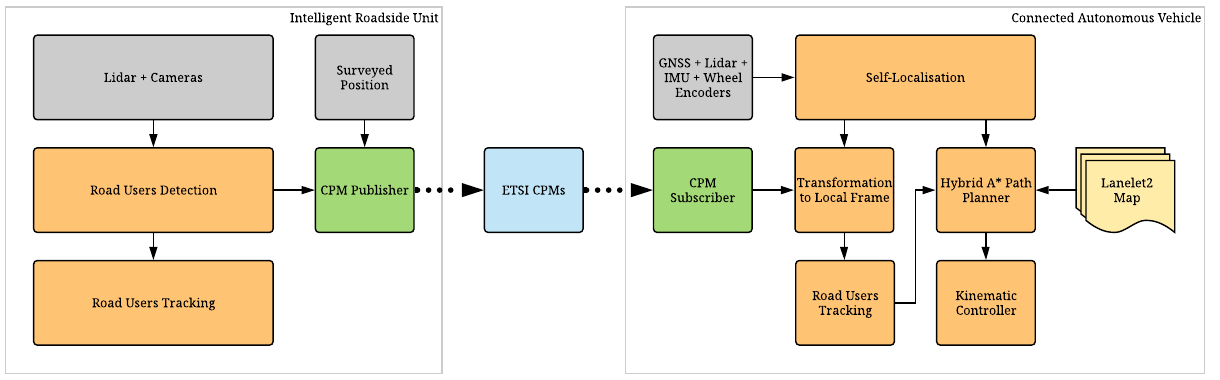
Figure 6. System diagram of the IRSU and the CAV platforms in the